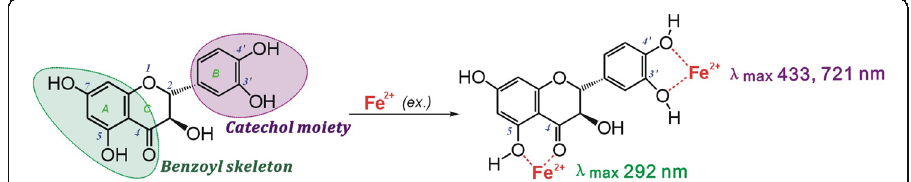
Fig. 4 Proposed reaction of (+) taxifolin binding to Fe 2+ (including UV-Vis spectra